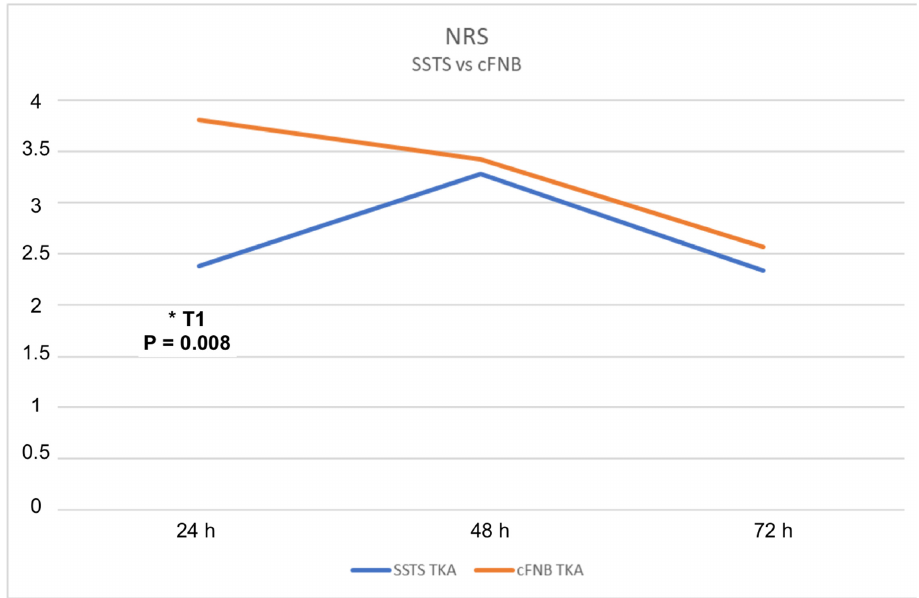
Figure 2. NRS were lower in the SSTS group compared to cFNB group at each time points measured with significant different in T1 ( p = 0.008) *. The NRS evaluated at T2 and T3 and compared between the two groups was not statistically significant (Figure 3).